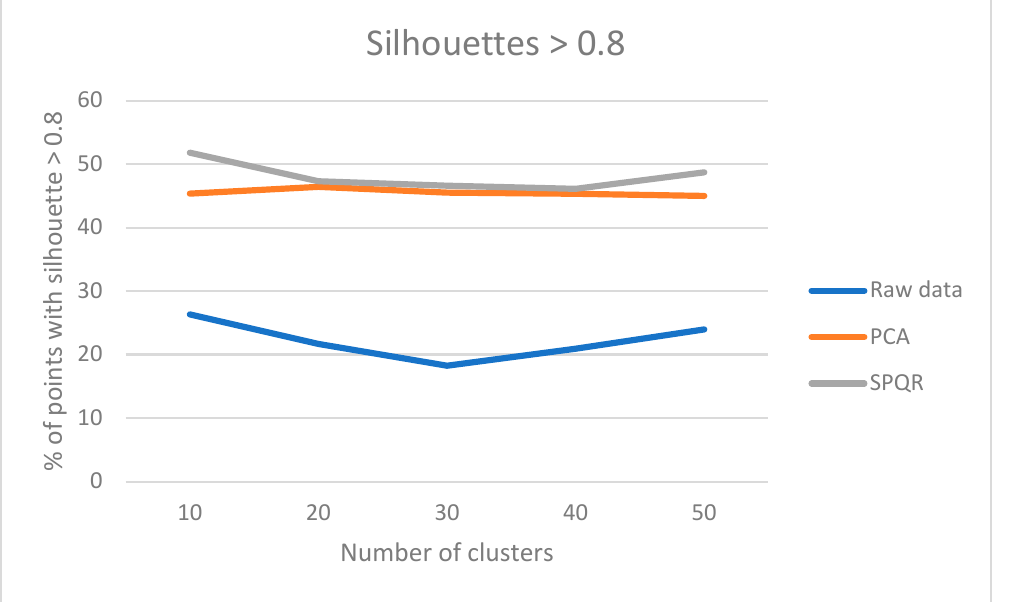
Figure 2. Mean results in terms of silhouettes >0.8 obtained by varying the number of clusters from 10 to 50.